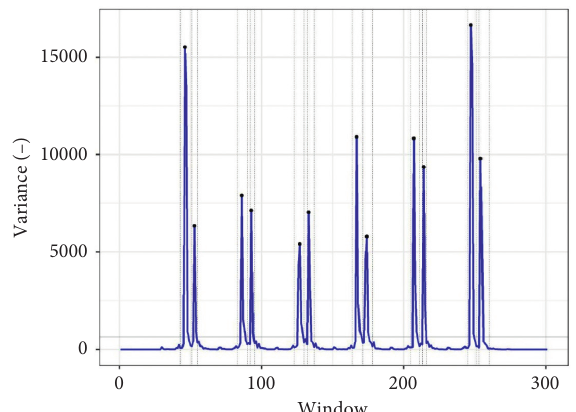
Figure 7: Peak detection of windowed variance. Window size: number of samples/300. Defines the area in the time domain; the analysis is then conducted in the frequency